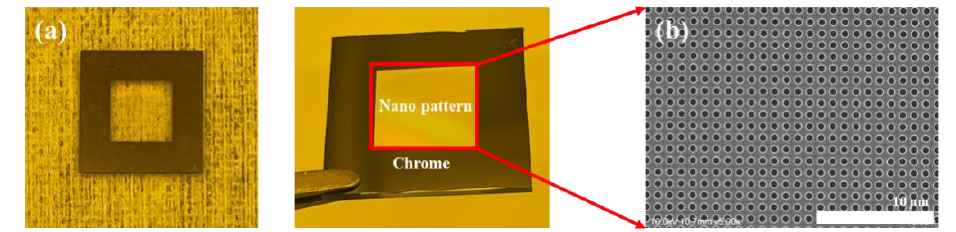
Figure 1. ( a ) Nanopattern stamp with deposited chromium and ( b ) 600 nm diameter nanohole structure.